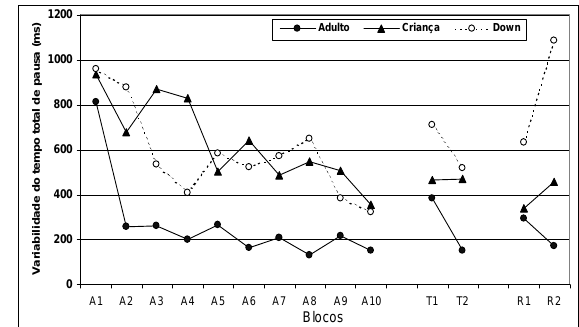
Figura 6. Mediana da variabilidade do seqüenciamento ao longo das fases para os três grupos.